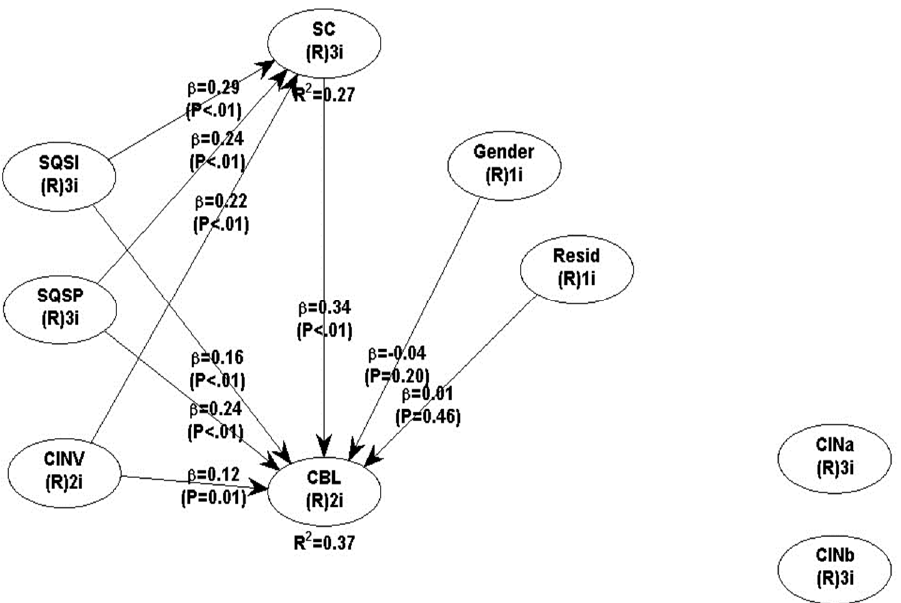
Figure A1. The first structural equation model—clothing brand loyalty (CBL) is the outcome variable.